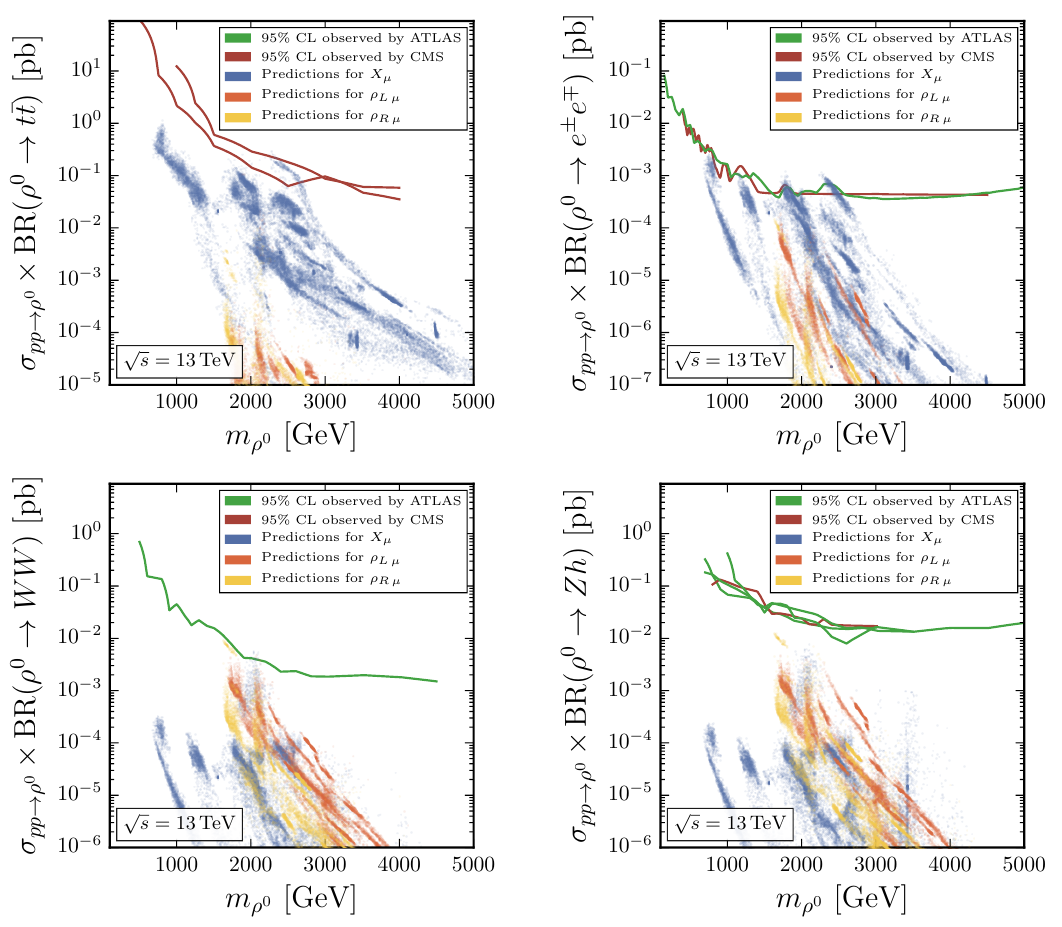
Figure 6 . Experimental bounds from ATLAS and CMS and predictions for the neutral vector resonance production cross section times the branching ratio into t (cid:22) t (top-left), e + e (cid:0) (top-right), WW (bottom-left) and ZH (bottom-right). We show values for the resonances X (cid:22) , (cid:26) L(cid:22) and (cid:26) R(cid:22) for the viable parameter points. The analyses included in the plots are listed in table